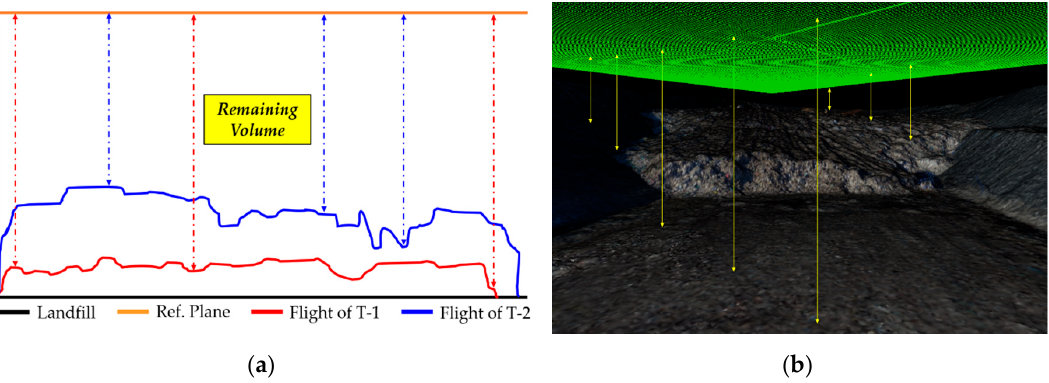
Figure 6. DEMs according to the chronology of data acquisition dates.